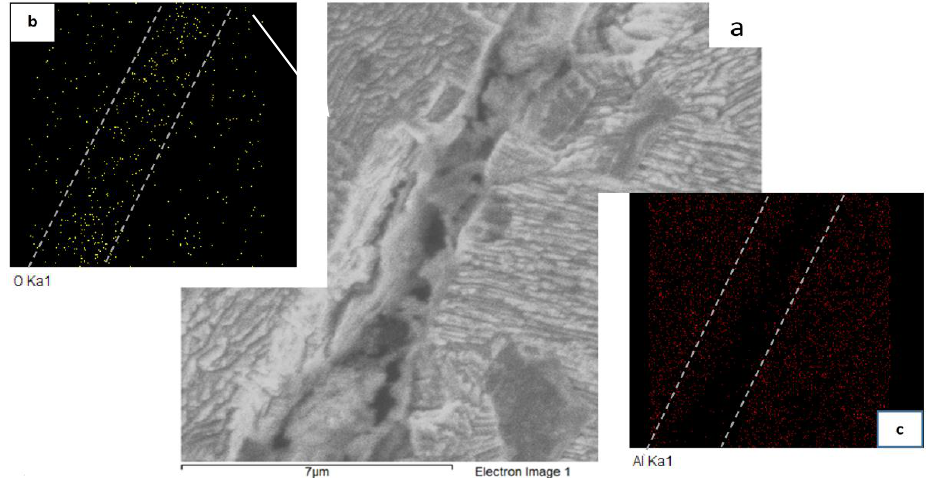
Figure 13. EDX mapping of oxide layer around kissing bond: ( a ) SEM image of kissing bond; ( b ) distribution of oxygen around the kissing bond in yellow color; and ( c ) distribution of Al around kissing bond in red color.